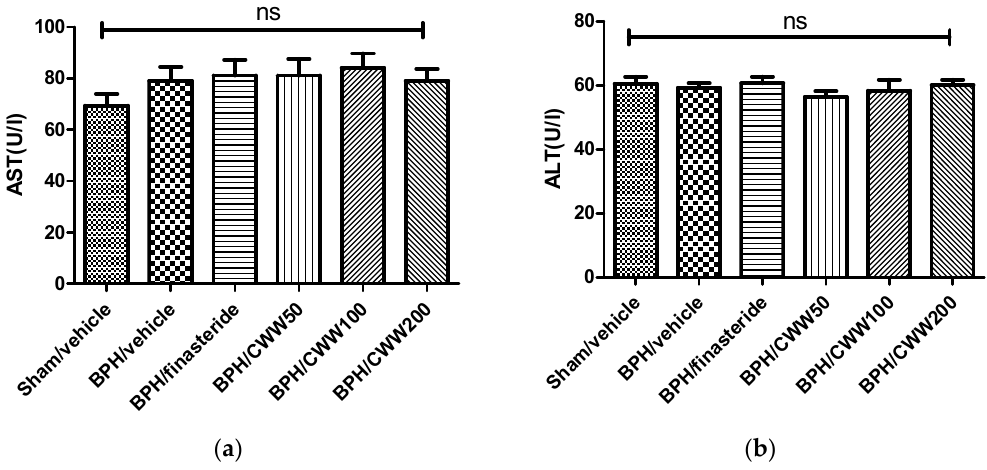
Figure 6. Levels of serum ( a ) aspartate aminotransferase (AST) and ( b ) alanine aminotransferase (ALT). BPH: benign prostatic hyperplasia; Sham/vehicle: sham-operated and phosphate-buffered saline (PBS), oral (p.o.); BPH/vehicle: testosterone, subcutaneous (s.c.) and PBS, p.o.; BPH/finasteride: testosterone, s.c. and finasteride 5 mg/kg, p.o.; BPH/CWW 50: testosterone, s.c. and CWW 50 mg/kg, p.o.; BPH/CWW 100: testosterone, s.c. and CWW 100 mg/kg, p.o.; BPH/CWW 200: testosterone, s.c. and CWW 200 mg/kg, p.o.